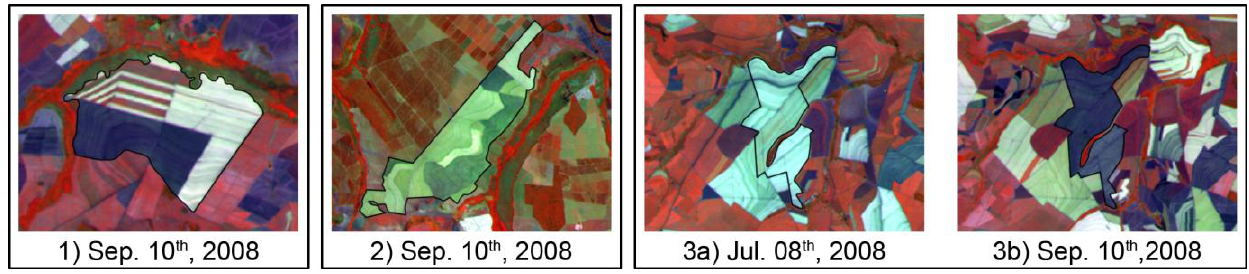
Figure 3. Examples of evident sugarcane fields harvested without straw burning that appear quite bright ( 3.1 and 3.3a ) and examples of not so evident sugarcane fields harvested without straw burning that appear in greenish color ( 3.2 and 3.3b ). Dark blue fields that appear in almost all figures are typical of sugarcane harvested with straw burning.